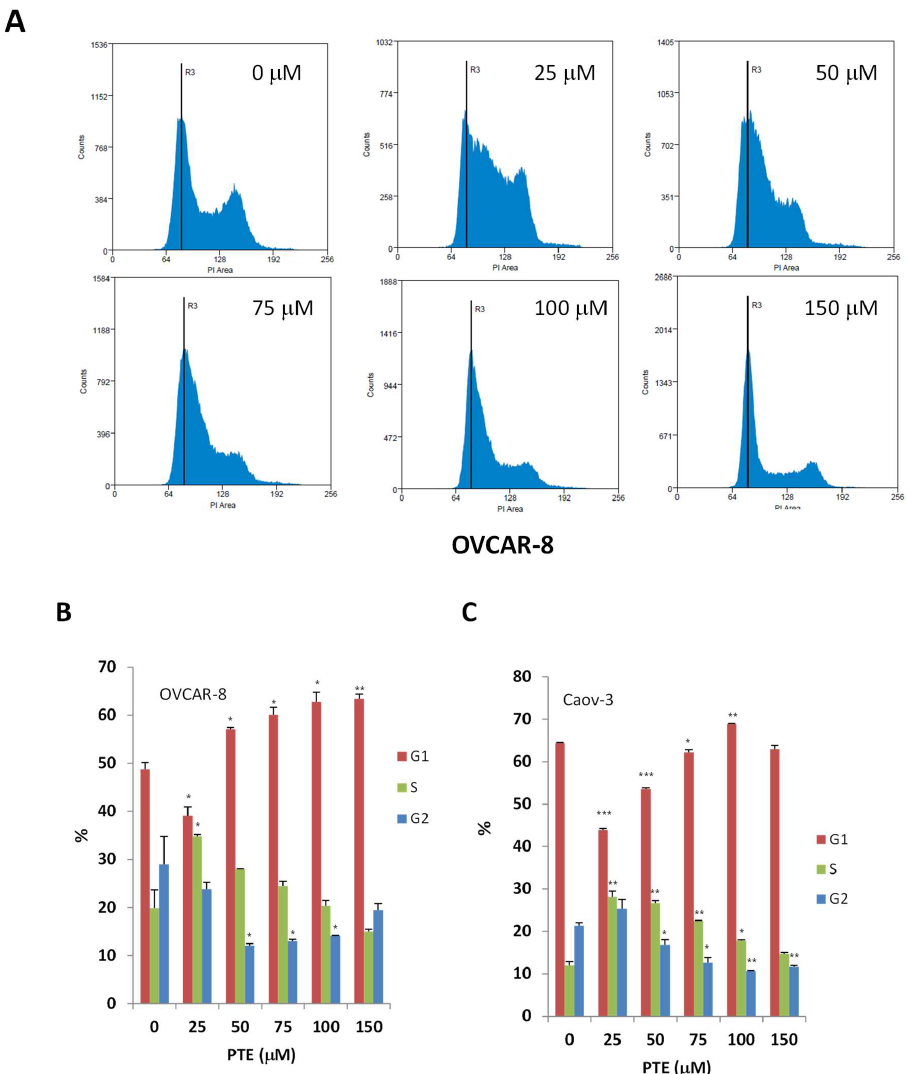
Figure 2. Pterostilbene suppresses cell cycle progression. OVCAR-8 and Caov-3 Cells were treated with vehicle and PTE (25–150 μm) for 24 h. The treated cells were labeled with PI for DNA contents and analyzed by flow cytometry. ( A ) Representative histograms of cell cycle analysis of OVCAR-8. ( B , C ) Cell cycle distribution of OVCAR-8 and Caov-3. The data indicate the percentage of cells in each phase of cell cycle. Results are representative of 3 or more preparations. *, p < 0.05, **, p < 0.005, ***, p < 0.0005, versus control treated with vehicle.